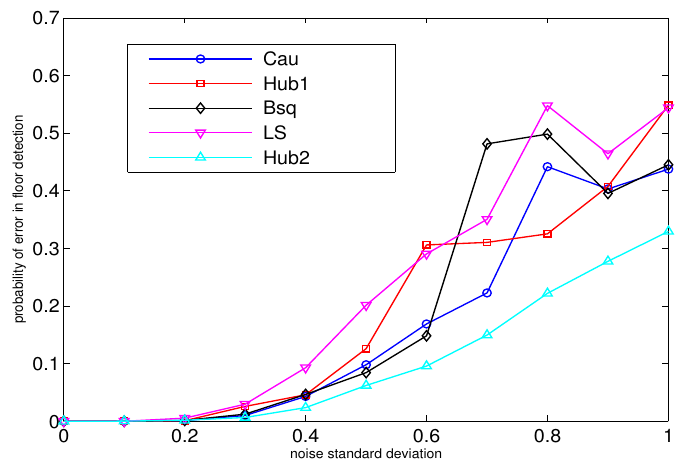
Figure 5. The performance of linear trilateration approaches for different robust weight